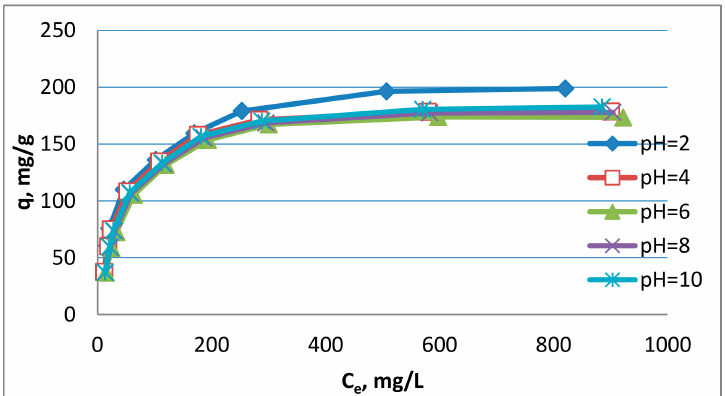
Figure 5. E ff ect of solution pH on the e ff ectiveness of chloramphenicol adsorption on activated carbon